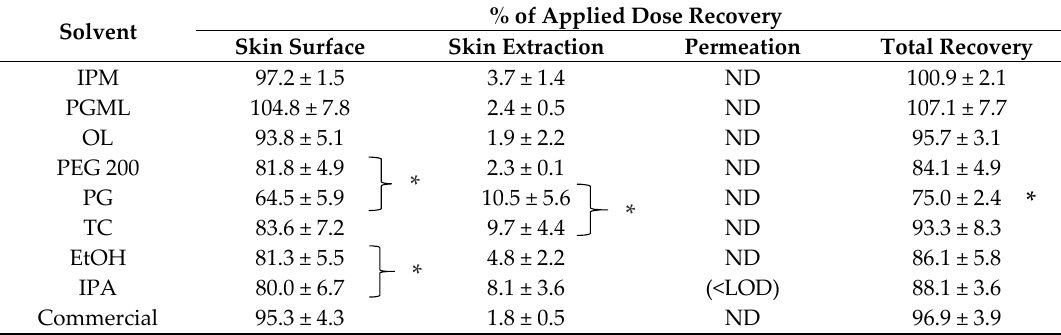
Table 1. Percentage of TBF-free base recovered from the skin surface, following skin extraction and percentage permeation for finite doses of 1% ( w / w ) TBF-free base formulations and commercial control in porcine skin (4 ≤ n ≤ 5, mean ± SD).